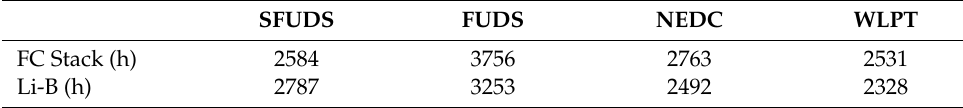
Table 9. Comparison of expected lifetime (Psplit1: δ = 1).